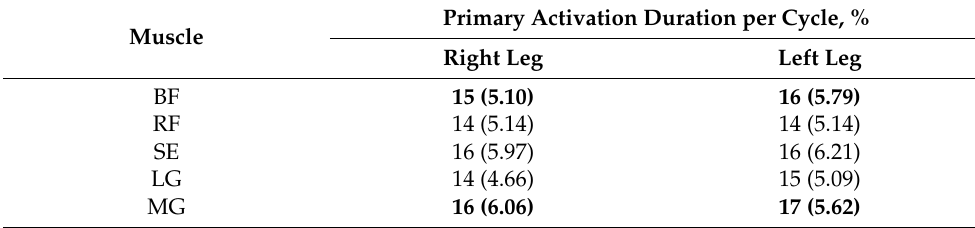
Table 3. Average (SD) activation duration of each muscle per full cycle for the right and left legs.